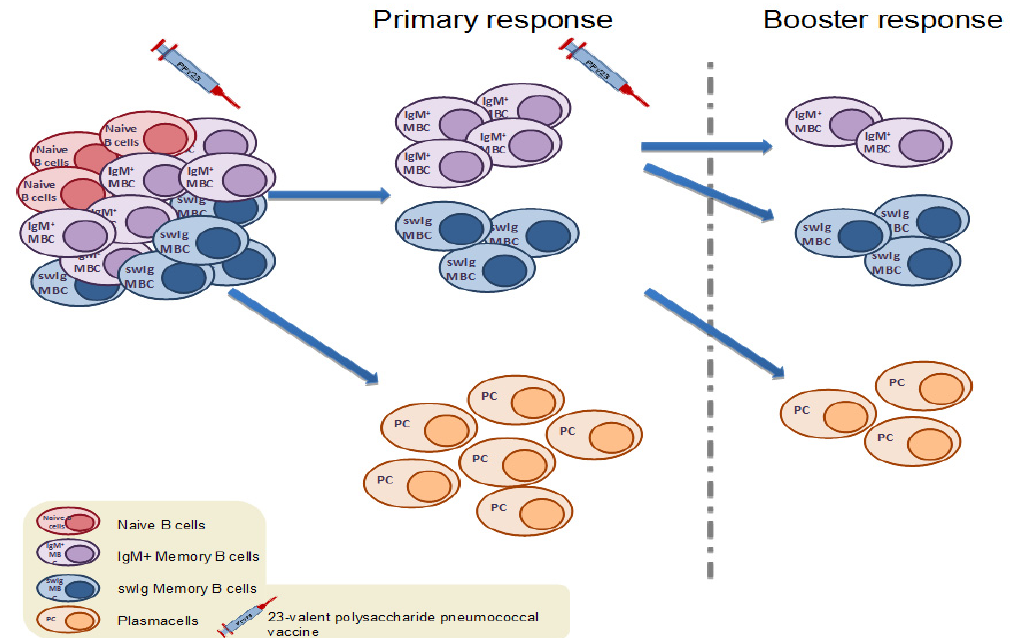
Figure 2. Upon primary vaccination with the 23-valent plain polysaccharide pneumococcal vaccine (PPV23), antigen-specific naïve B cells, as well as pre-existing antigen-specific MBCs formed by colonization or disease, are activated and differentiate into short-lived plasma cells (PCs) [52]. Booster immunization with PPV23 leads the remaining antigen-specific MBCs to terminally differentiate into PCs, thus resulting in further depletion of the antigen-specific MBC pool. This phenomenon is known as immune hyporesponsiveness [24].